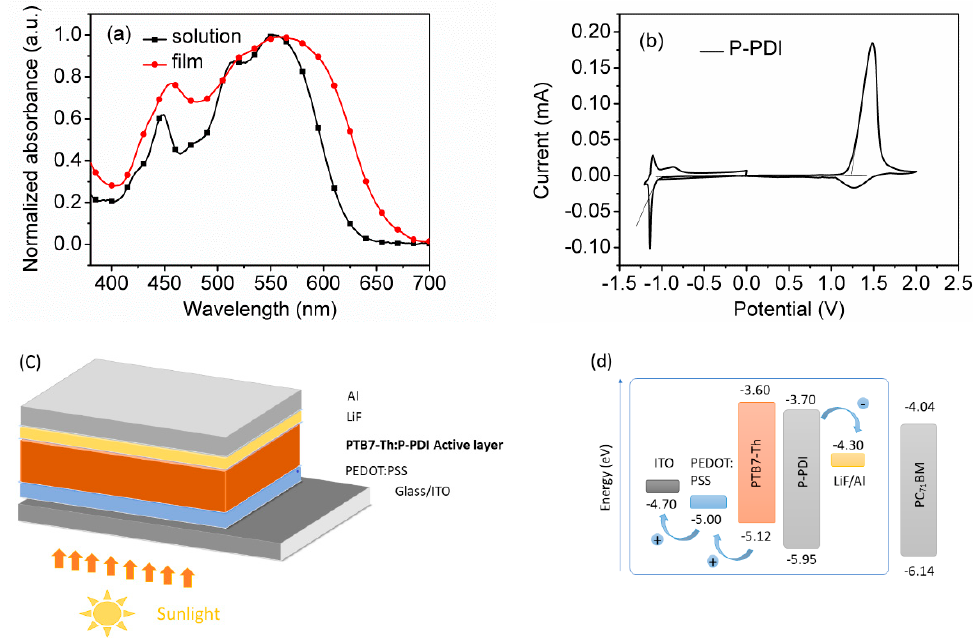
Figure 1. ( a ) Ultraviolet–visible spectroscopy (UV-vis) absorption spectra of P-PDI in solutions and as films; ( b ) cyclic voltammetry (CV) curve of P-PDI; ( c ) Device structure for polymer solar cell (PSC) devices; ( d ) Molecular orbitals of PTB7-Th:P-PDI and PC 71 BM.